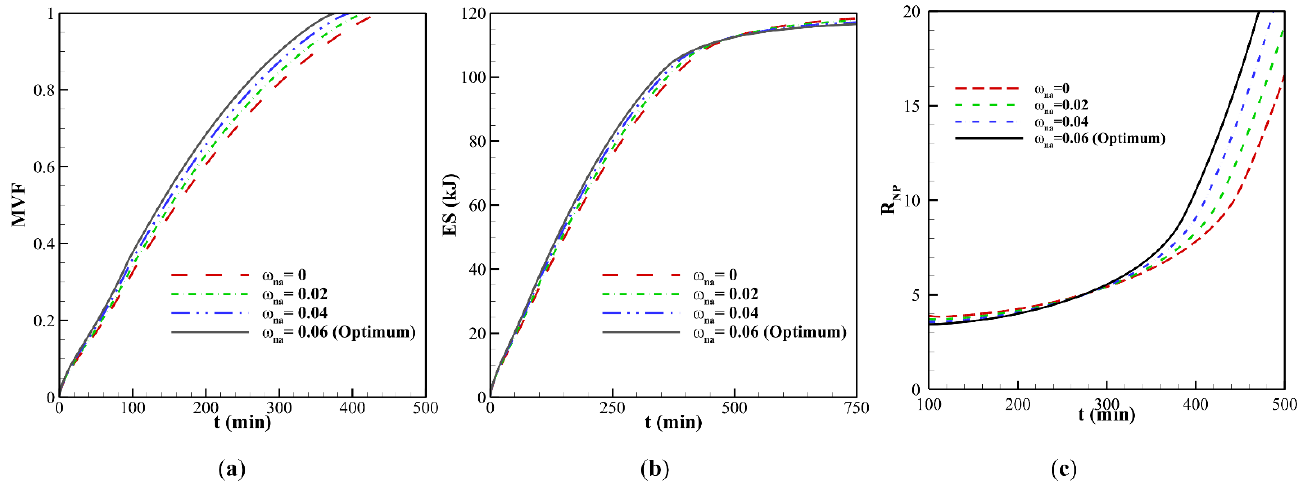
Figure 7. Effect of volume fraction (ω na ) for A = 0 mm. on the: ( a ) melting volume fraction; ( b ) total energy storage; ( c ) thermal resistance at NePCM side.